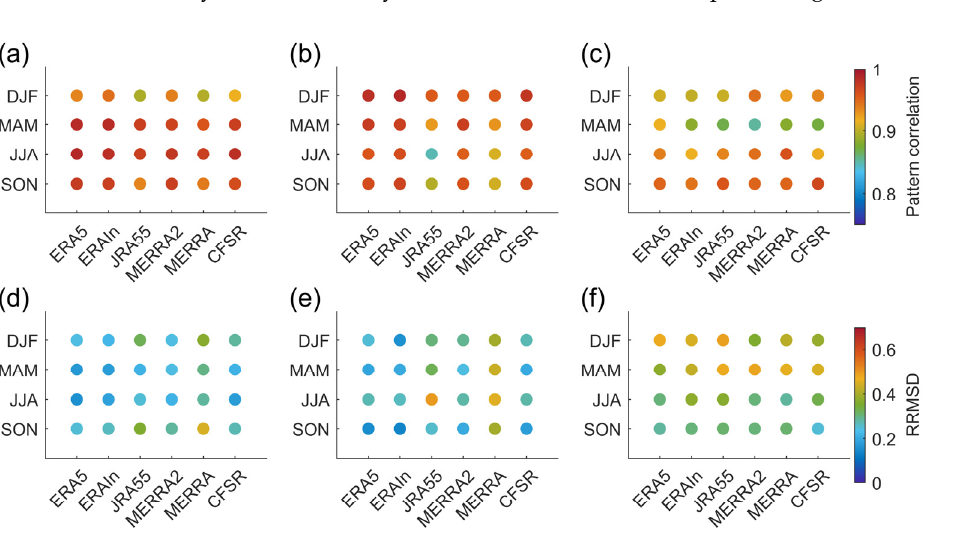
Figure 9. The pattern correlation (PatCor) coefficients and RRMSD of reanalysis and observational spatial patterns at the station locations for the leading three modes for each season. ( a , d ) show the pattern correlation and RRMSD for the first mode. ( b , e ) and ( c , f ) are same as ( a , d ), but for the second and third modes, respectively.